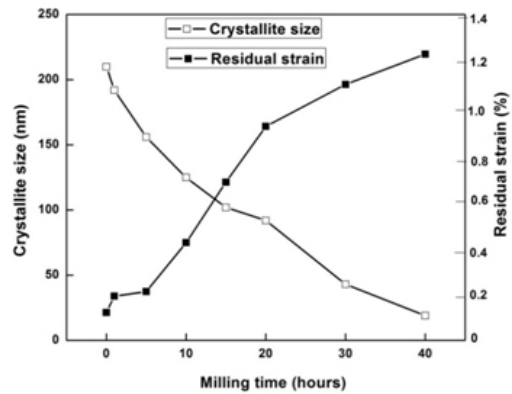
Fig. 2 Variation in crystallite size and residual strain with milling times of pre-alloyed powder (alloy